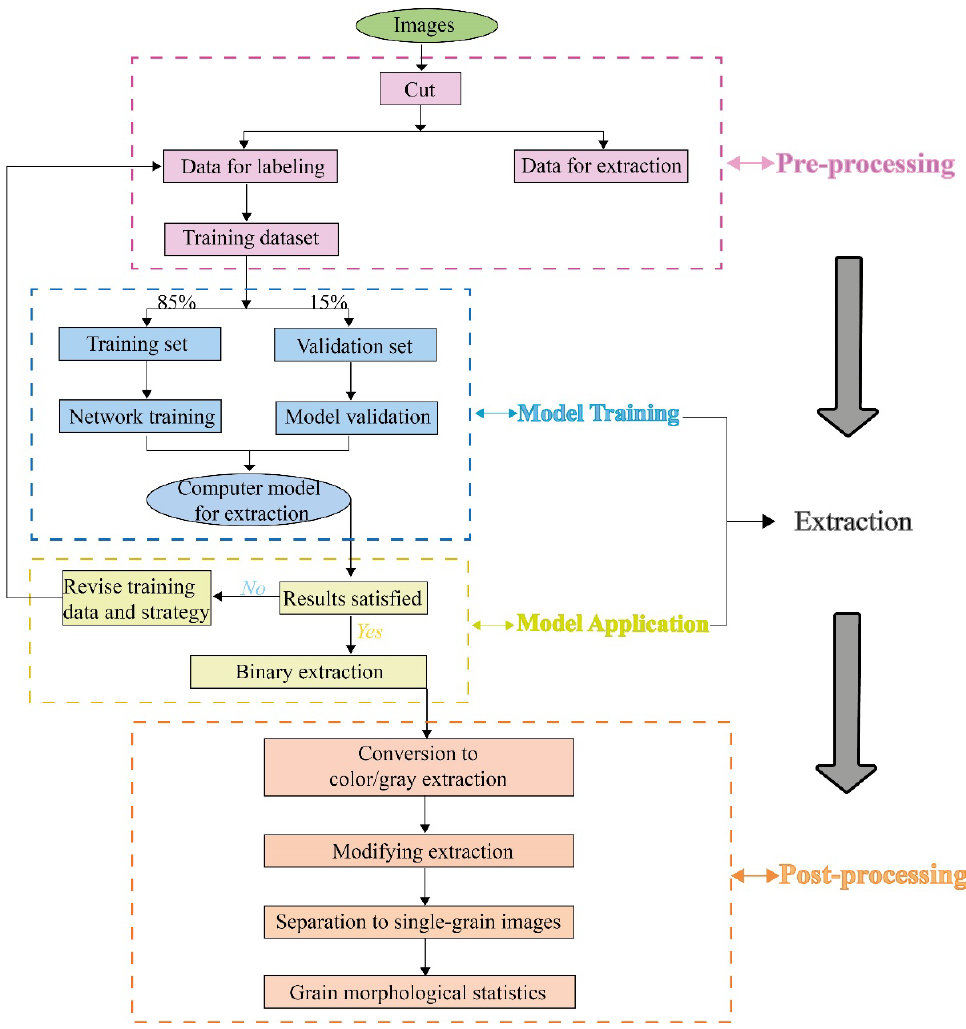
Figure 1. Image processing workflow